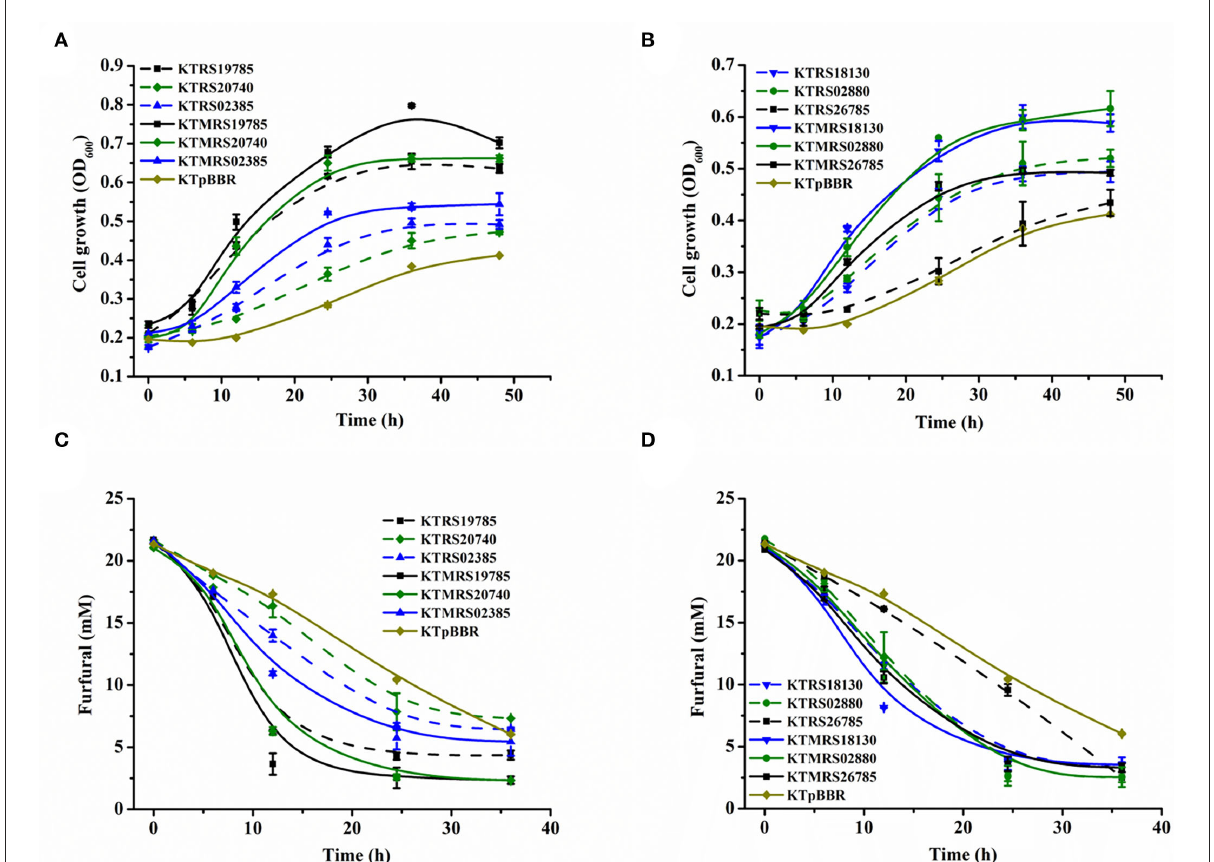
FIGURE4 Comparison of the effects of strains overexpressing wild-type genes and overexpressing mutated genes on furfural tolerance. The growth curve (A) and furfural conversion (C) of strains overexpressing wild-type genes and overexpressing mutated genes PP_RS19785, PP_RS20740, PP_RS02385, and the control (pBBR1MCS2); The growth curve (B) and furfural conversion (D) of strains overexpressing wild-type genes and overexpressing mutated genes PP_RS18130, PP_RS02880, PP_RS26785, and the control (pBBR1MCS2). All data are the mean value ± standard deviation of independent two